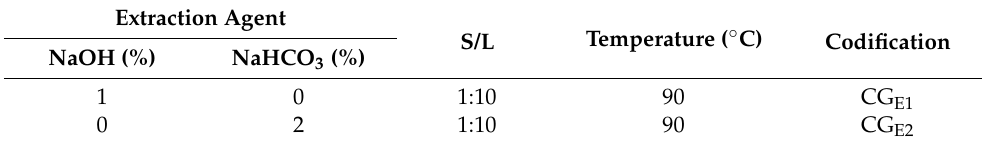
Table 1. GC Extraction conditions on the extraction